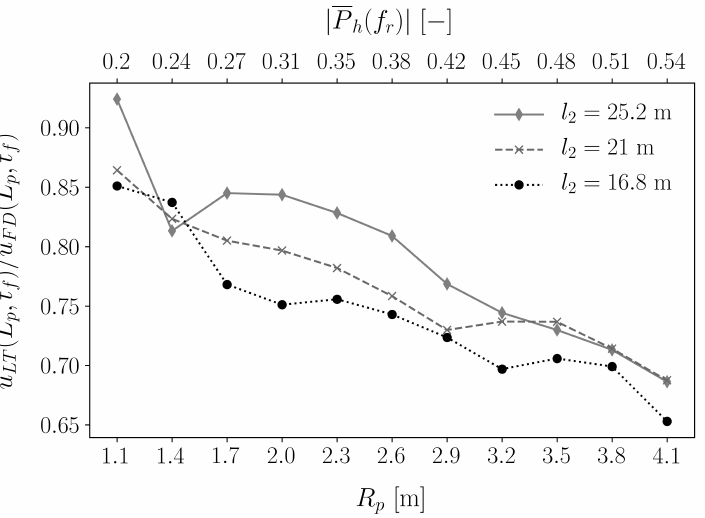
Figure 7. Ratios of ultimate set obtained by 3-d LT model to 1-d FD model, u LT ( L p , t f ) / u FD ( L p , t f ) , for the all considered pile radii, R p and initial embedment depths, l 2 .